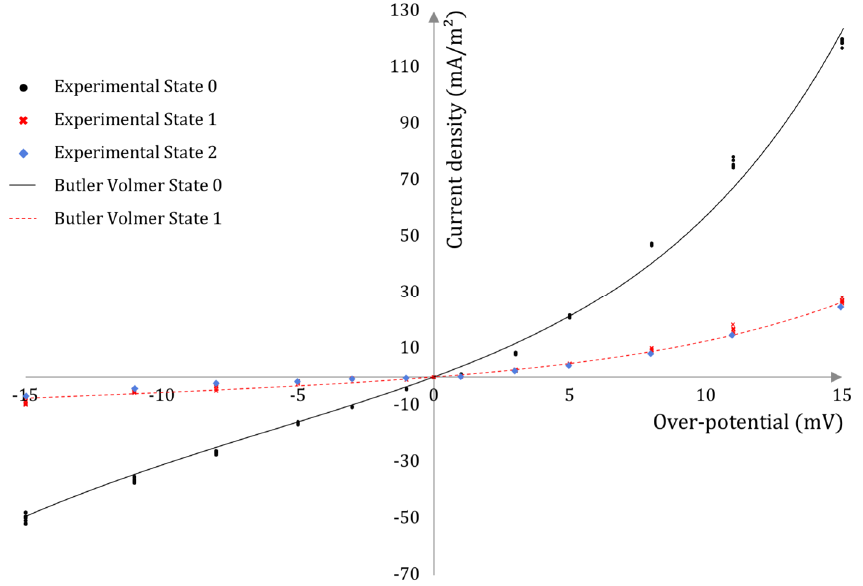
Figure 7 . Polarization curves of zinc sheet for initial and aged